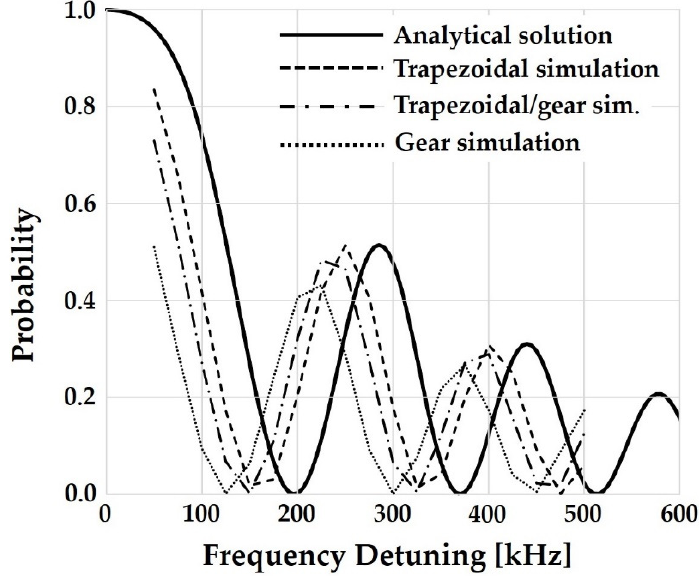
Figure 4. Chevron cross-sections for P 0 for the second peak of the Rabi oscillation ( τ p = 5.067 μ s).